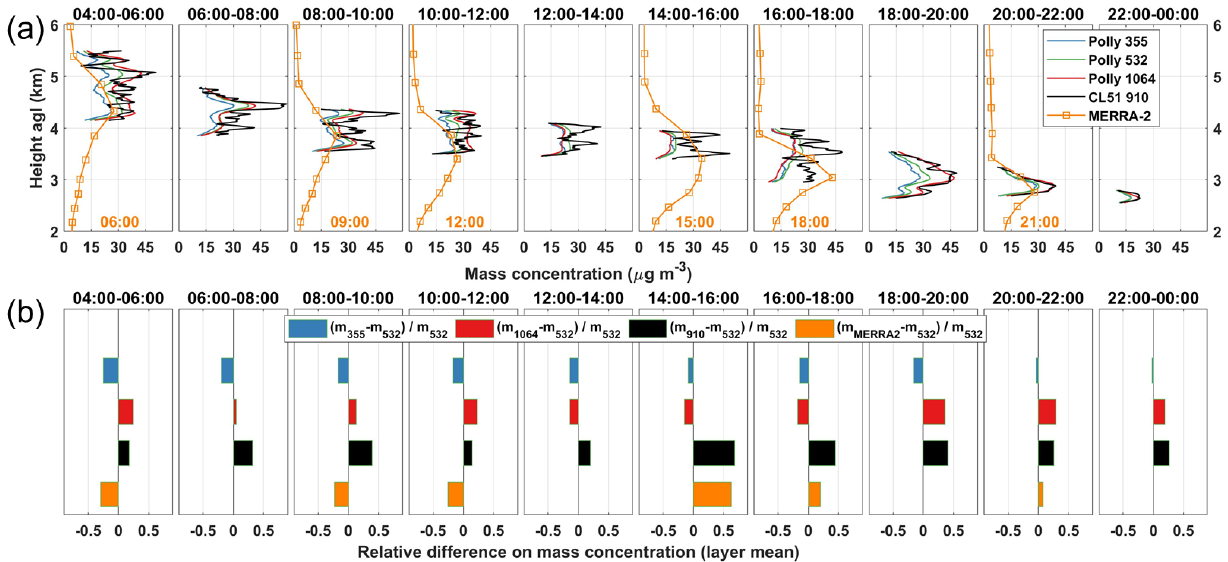
Figure 7. (a) Estimated mass concentration profiles for the SPoI (smoke plume of interest), based on parameters in Table 2, method no. 2, using corresponding measured backscatter coefficients (BSCs, Fig. 5a). Mass concentrations from the MERRA-2 model are also shown in orange color with the corresponding time given at the bottom right of each panel. The uncertainties are discussed in Sect. 3.2.2. (b) Relative differences in the mass concentrations (denoted as m ) estimated from measured BSCs and the MERRA-2 model, using the one from measured BSC at 532nm as the reference. Two-hour time-averaged lidar profiles are used, with the time slot (UTC) on 5 June 2019 given at the top of each